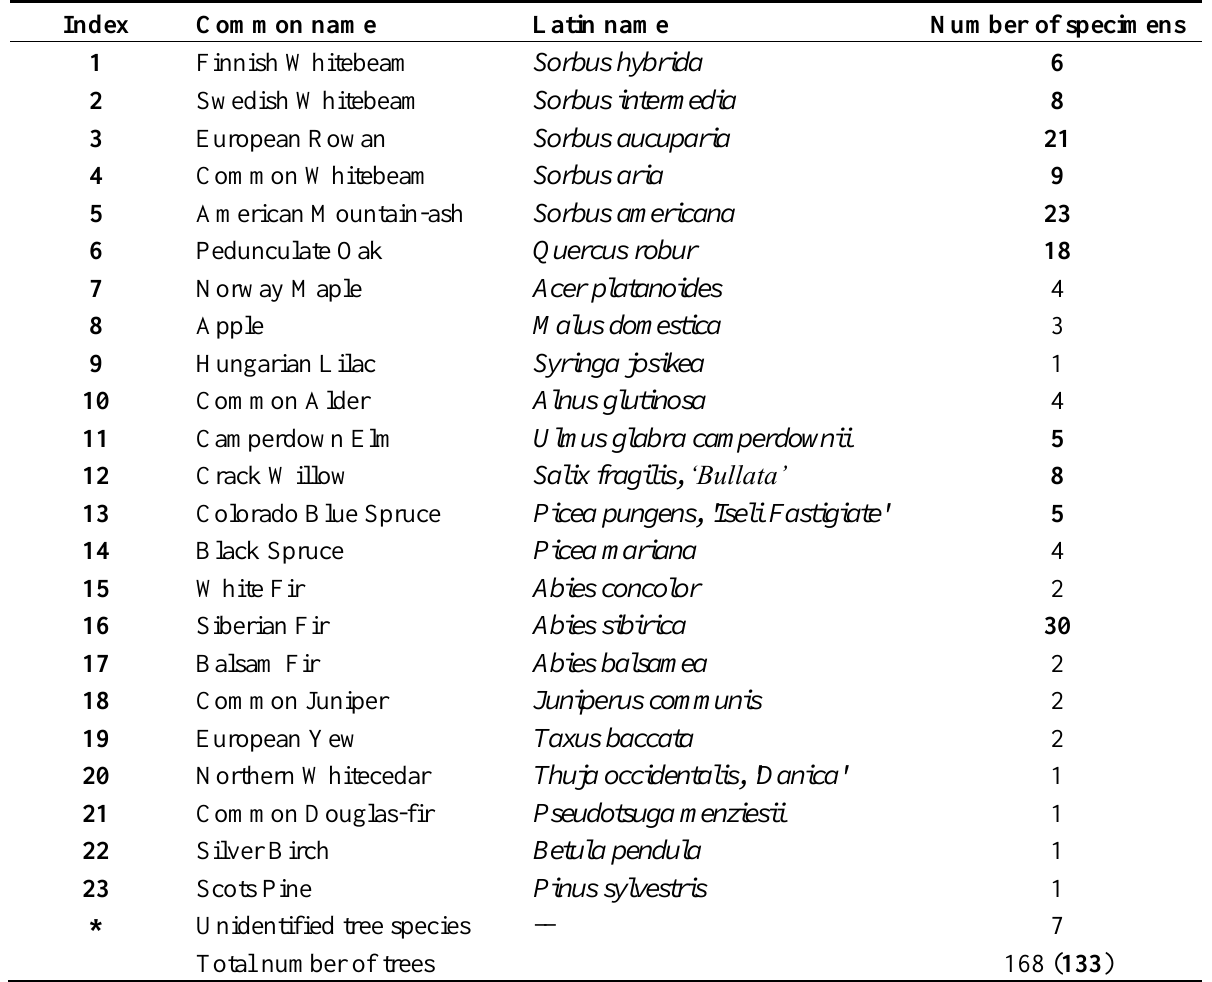
Table 1. Classified tree species and their specimen numbers. All listed tree specimen were used in coniferous-deciduous tree separation. The tree species with the specimen number in bold were also used in individual tree species classification. Five of the specimens labelled as unidentified were deciduous and two specimens were